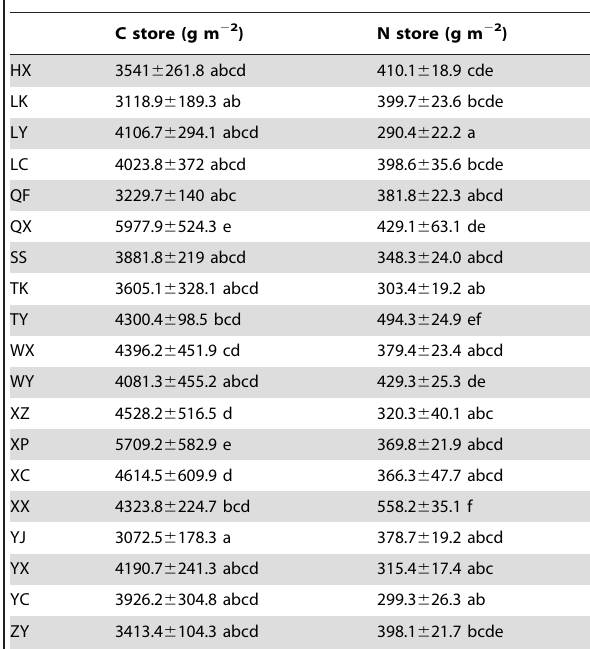
Table 3. Total C (TSOCS) and N (TSNS) stores in the surface soil layer (0–40 cm) of soils in 19 counties in Henan Province, China.